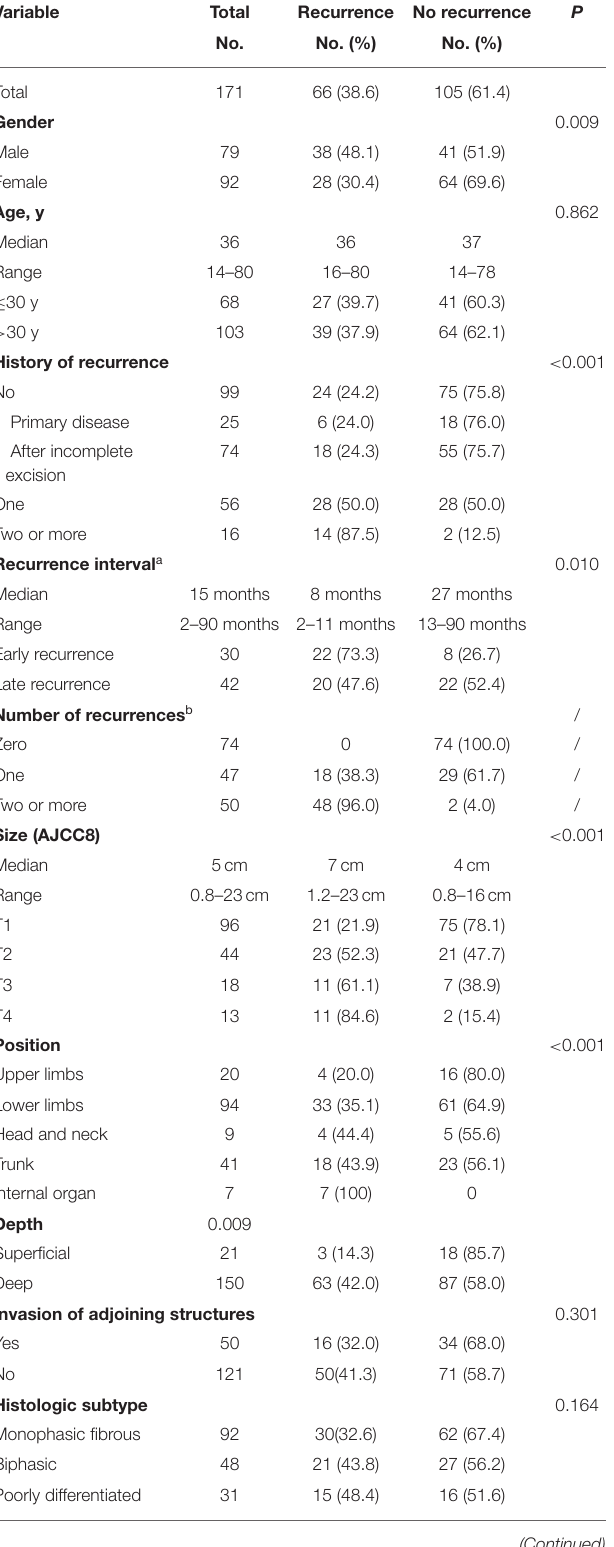
TABLE 1 | Clinical, pathological, and therapeutic information of 66 cases with local recurrence and 105 cases without recurrence after surgery at our center.